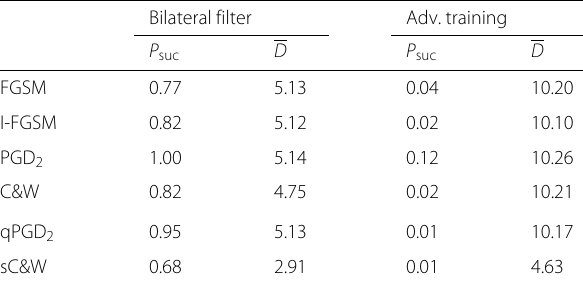
Table 3 Success probability and average L 2 distortion D of attacks on variants of InceptionV3 under transferability Bilateral filter